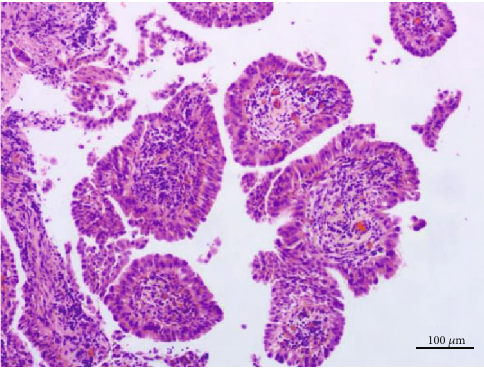
Figure 11: Papillary adenoma stained with TTF1, × 100.